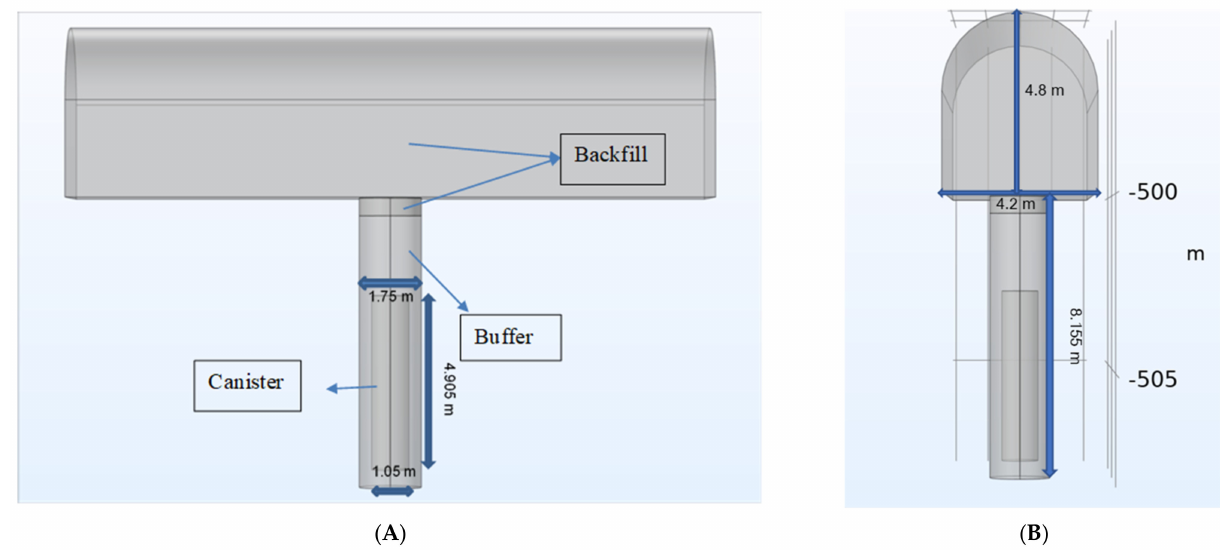
Figure 1. Schematic illustration for EBS design: ( A ) front view; ( B ) side view. (The EBS is located at a depth of about 500 m below the ground surface. Minus sign denotes below the ground surface).